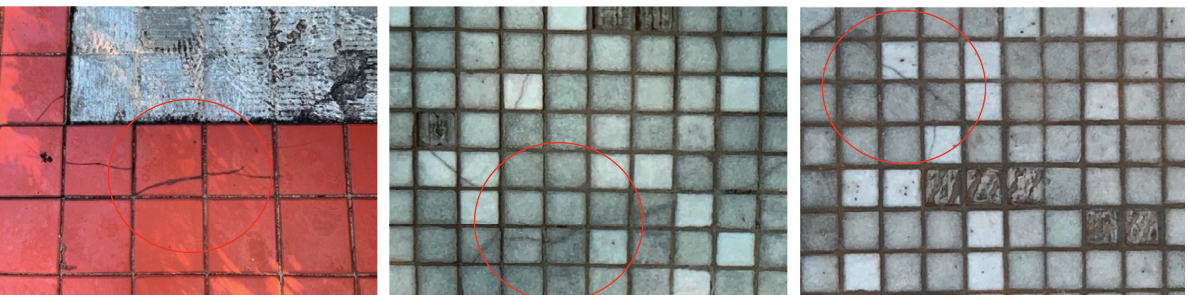
Figure 9: Cracking in spalled areas.